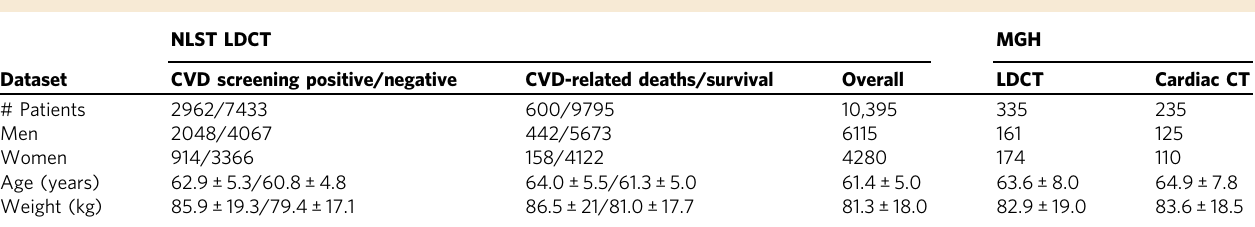
Table 1 Demographics of the two independent datasets used in this study.